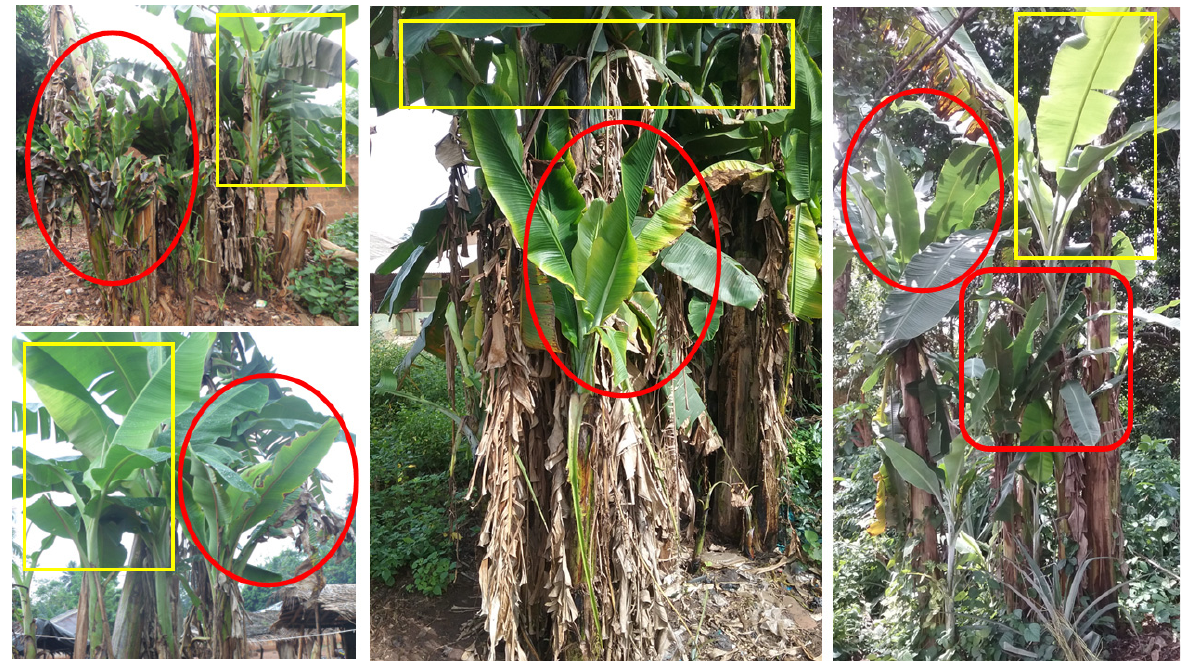
Figure 7. A few examples of banana bunchy top virus (BBTV)-infected banana mats in the farmers’ fields and backyards in the study area, captured in December 2020. Pseudostems with typical BBTV symptoms are indicated in red circles, and asymptomatic/uninfected banana shoots are indicated in yellow rectangles. BBTV-symptomatic plants are severely stunted, with narrow leaf lamina, and resemble suckers (young side shoots emerging from the pseudostem base). Images were taken manually using a 12-megapixel RGB camera from the ground level.